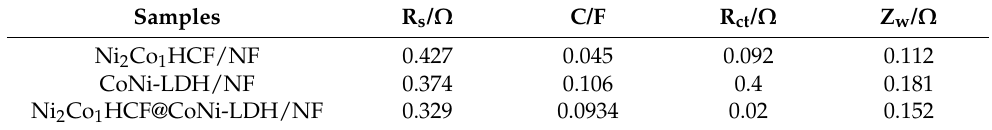
Table 1. Parameter values of the different samples obtained by the equivalent circuit